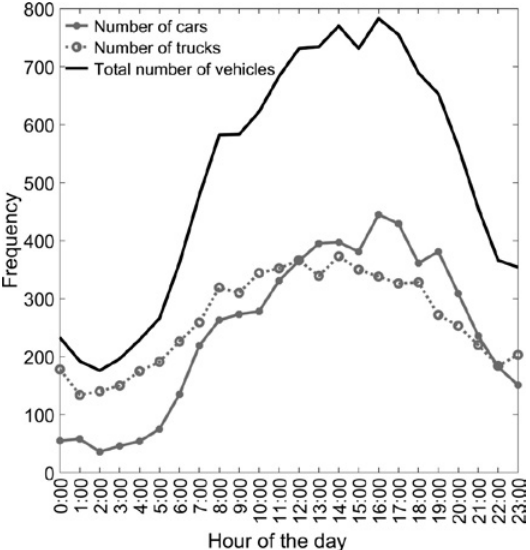
Figure 2. The frequency of car and truck data by time of day